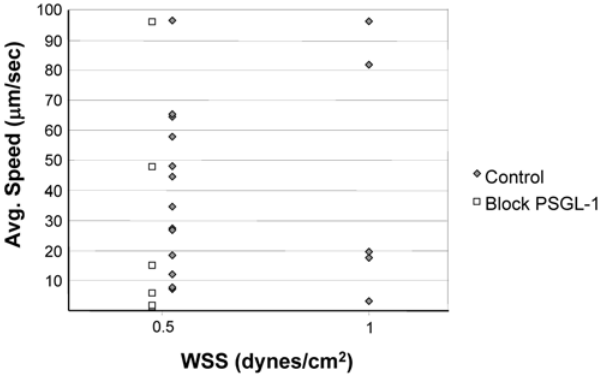
Figure 8. hASCs slowly rolled on immobilized P-selectin invitro at two levels of wall shear stress in the laminar flow assay, instituted in a parallel plate flow chamber. Reported are average quantified speeds of rolling cells below 100 m m/s. Adhesive interactions between hASCs and the substrate both above and below this speed were numerous (data not shown). Each point represents a single observed cell’s speed (gray diamonds; data pooled across 4–6 experiments). Interactions, however, were extremely rare and we estimate that less than 1% of hASCs slowly rolled on P-selectin in the laminar flow assay. Competitive inhibition of PSGL-1 was ineffective, as expected (white squares), while blocking immobilized P-selectin with competitive antibodies inhibited all rolling activity (data not shown). Video of the adhesive interactions between hASCs and immobilized P- selectin is available for download at the Peirce-Cottler laboratory website (http://www.bme.virginia.edu/peirce).